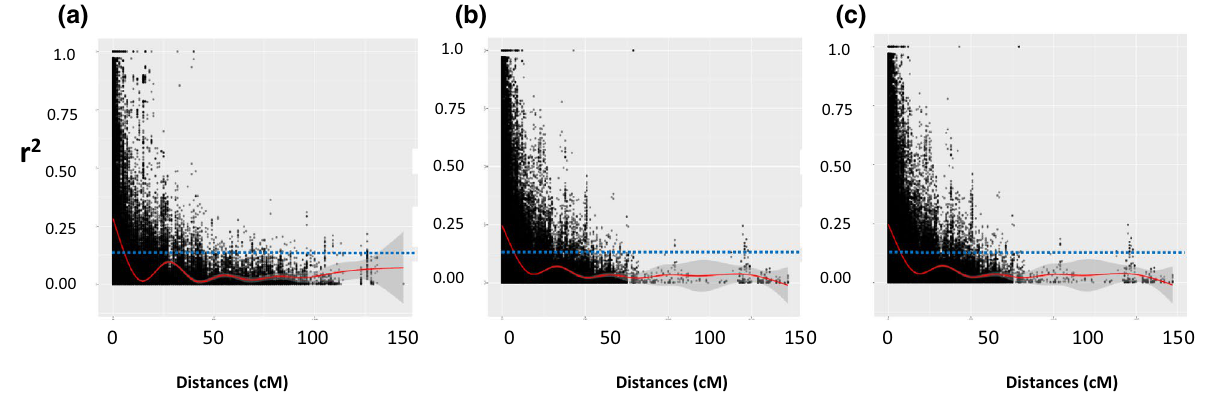
Figure 3. Linkage disequilibrium decay measured as r-squared against the genetic distance between pairs of SNPs. LOESS curve was fitted showing that LD decays with genetic map distance and dashed line indicates the derived threshold for LD due to linkage. ( a ) LD decay in A genome ( b ) LD decay in B genome ( c ) LD decay in D